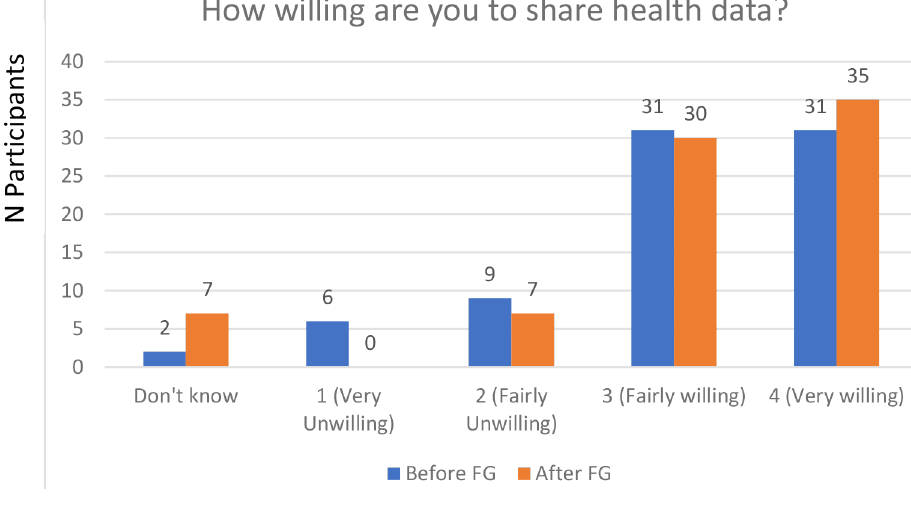
Figure 1: Willingness of participants to share their medical data for a research study